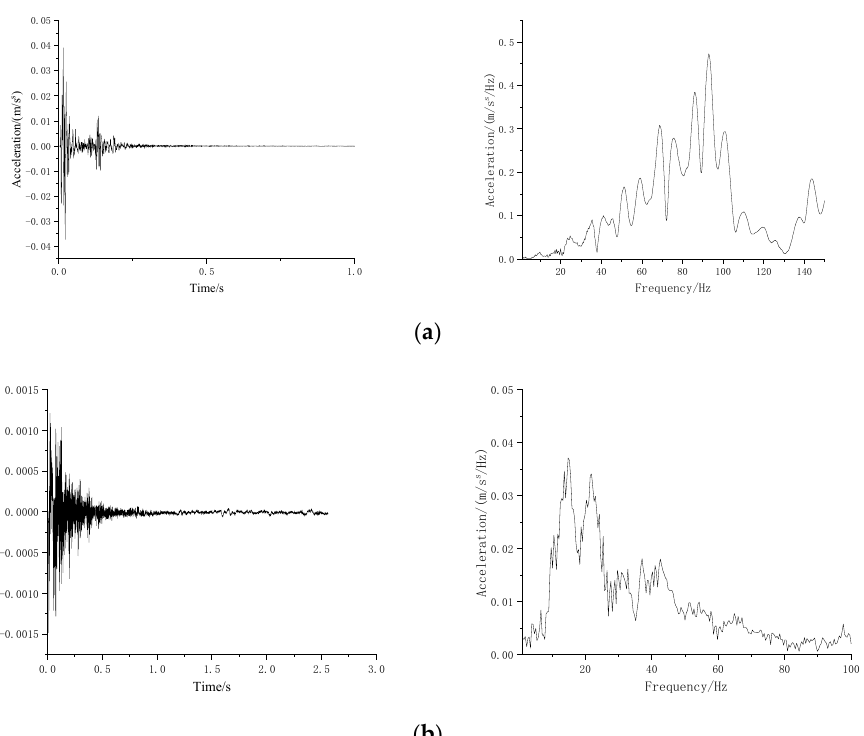
Figure 8. Typical time histories and Fourier spectra of vibration responses for the conditions ( a ) without and ( b ) with the mat. Insertion loss (IL) was used to evaluate the vibration reduction effect, defined as